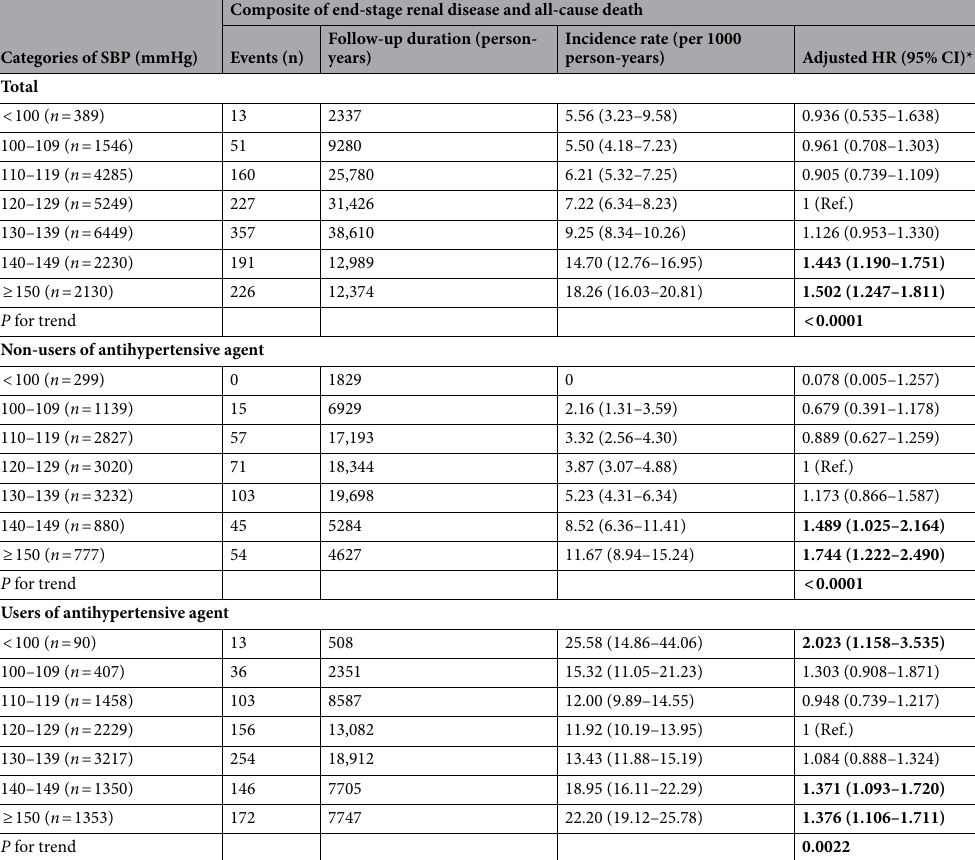
Table 2. Hazard ratios and 95% confidence intervals for the incidence of composite of end-stage renal disease and all-cause mortality according to the categories of systolic blood pressure among the individuals with chronic kidney disease. SBP systolic blood pressure, HR hazard ratio, CI confidence interval. *Adjusted for age, sex, current smoking, alcohol consumption, regular exercise, household income level, body mass index, presence of dyslipidaemia, diabetes mellitus, and urine dipstick positivity for protein. Adjusted HRs (95% CIs) and P-values, considered to be statistically significant in bold